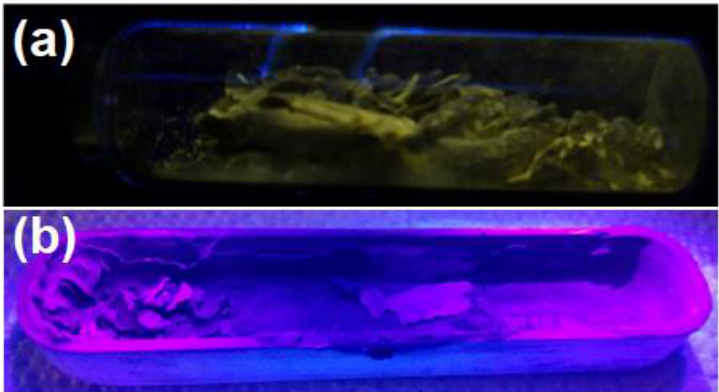
Figure 9. ( a ) Yellow luminescence of the undoped GaN powders; ( b ) violet-blue luminescence of the Mg-Zn co-dopedGaN powders.